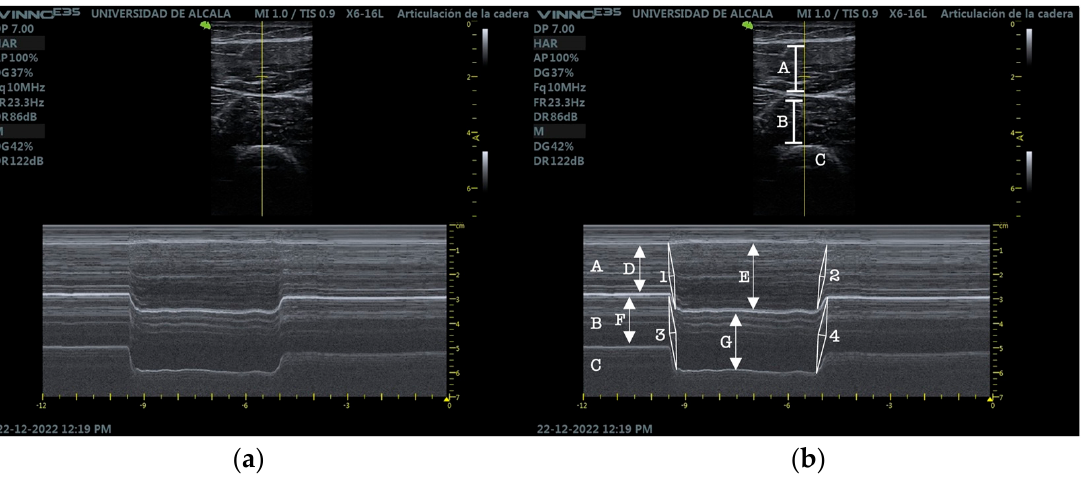
Figure 2. ( a ) RUSI M-mode RF and VIM. ( b ) RUSI M-mode RF and VIM measurements. RF (A), VIM (B), cortical bone of the femur (C), RF at rest (D), RF at isometric contraction (E), RF contraction velocity (1), RF relaxation velocity (2), VIM at rest (F), VIM at isometric contraction (G), VIM contraction velocity (3), VIM relaxation velocity (4).